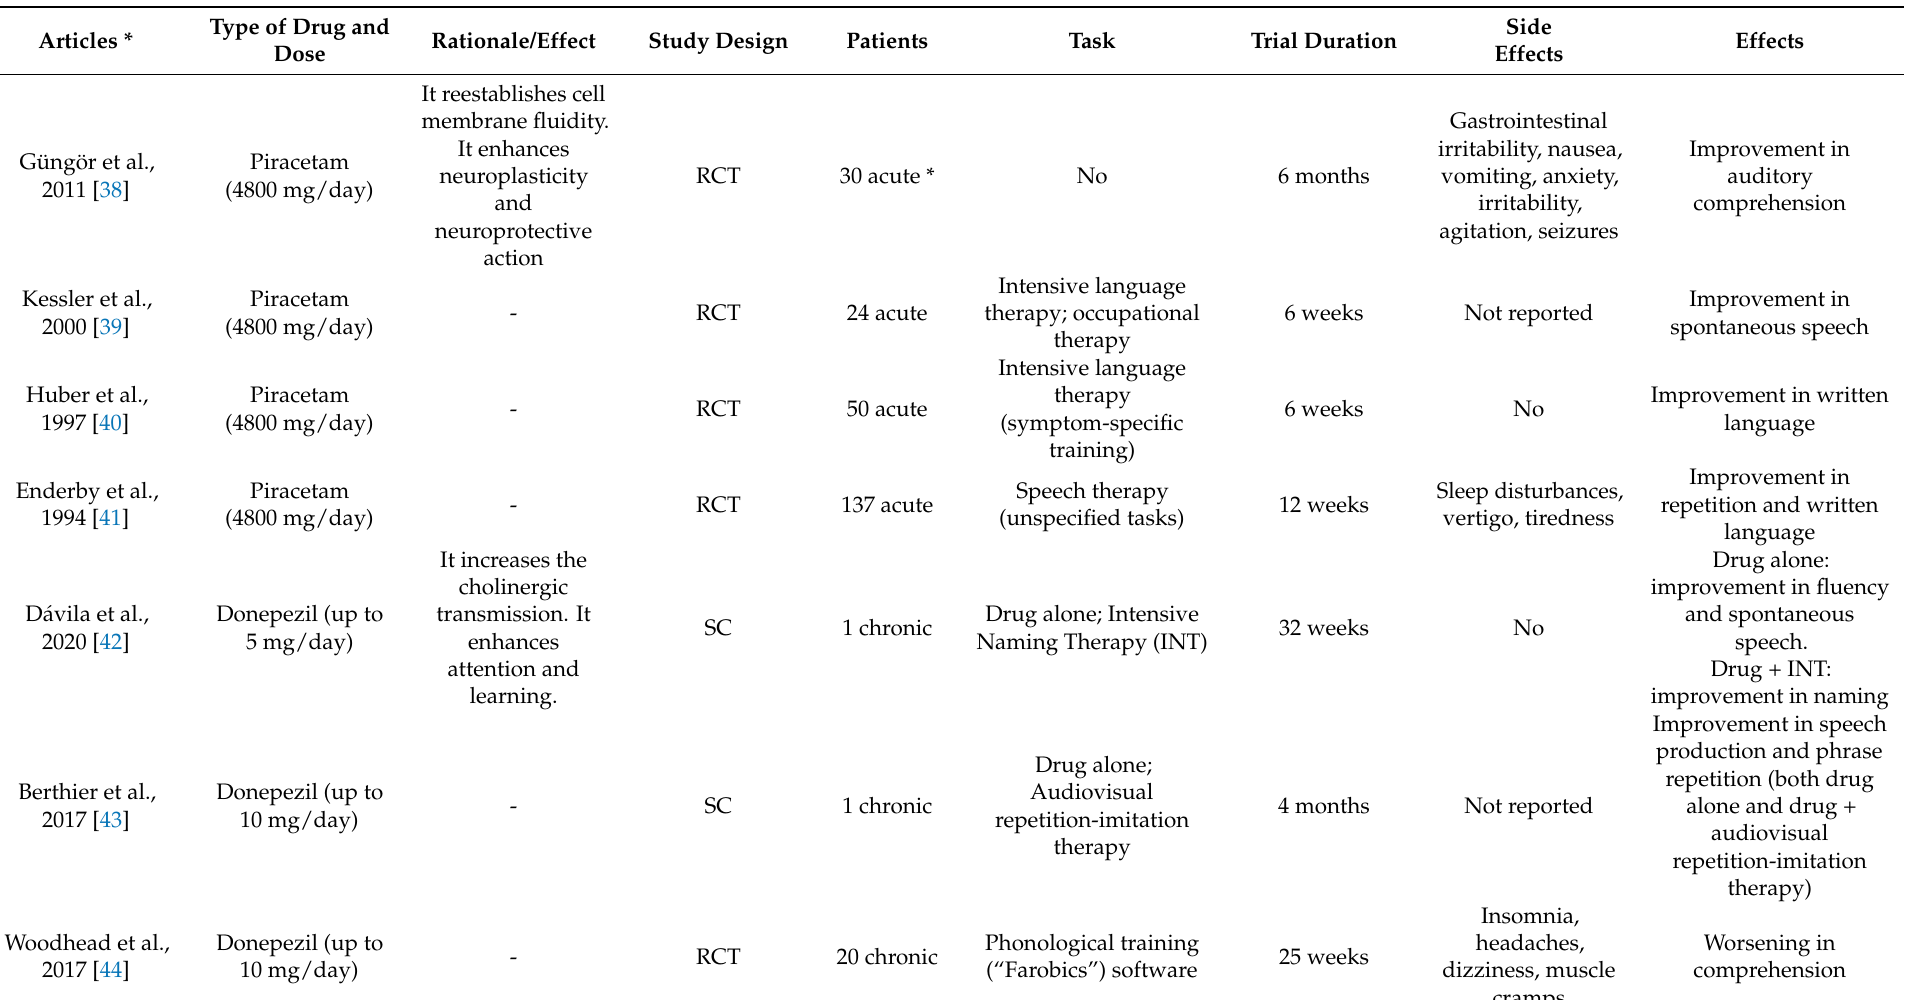
Table 1. Pharmacological studies in aphasia recovery. Abbreviations: * RCT: randomized controlled trial; SC: single case; CS: case series; OLT: Open-label trial; CT: Controlled- Trial not randomized; ERP: